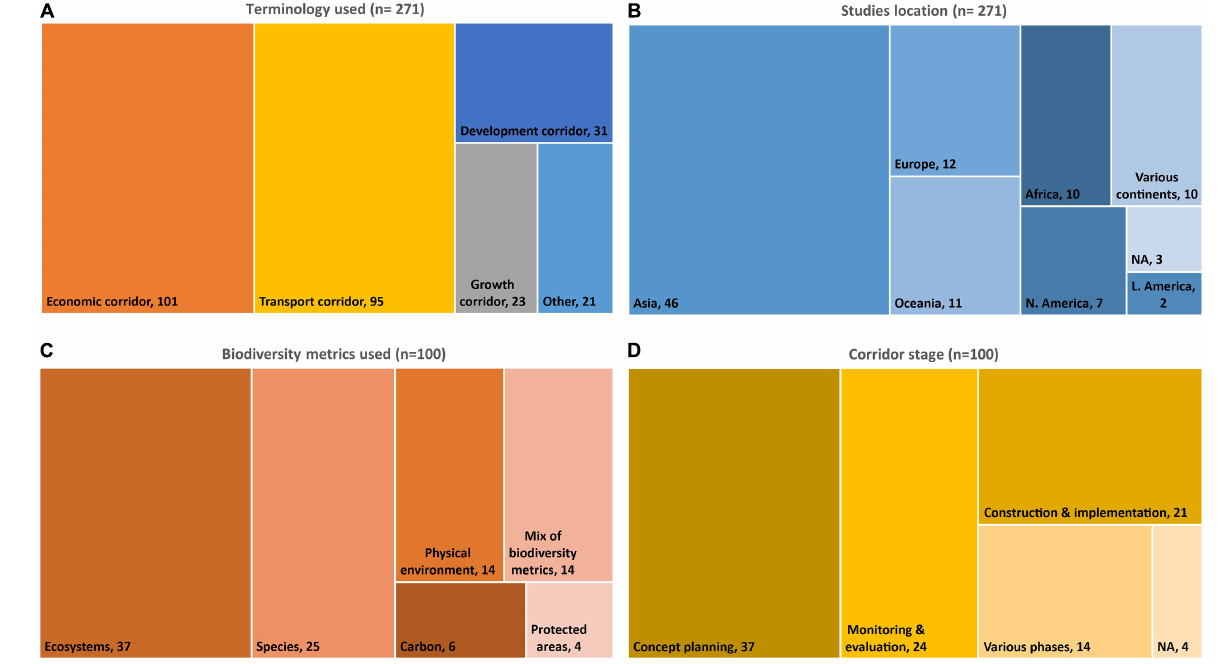
FIGURE 3 | Number of articles classified as (A) terminology used, (B) continental coverage, (C) metrics used, and (D) stage of corridor when assessment was conducted. n = 271 includes all abstracts that mentioned corridors in any of the search terms (Step 1). n = 100 includes abstracts where impacts on either biodiversity or ecosystem services were assessed (Step 2). NA = not applicable when the studies did not focus on a specific geographic location or when the corridor stage was not a consideration of the